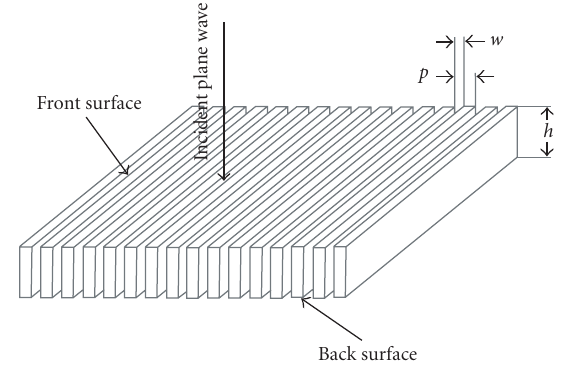
Figure 1: Schematic view of the metallic grating with subwave- length slits.